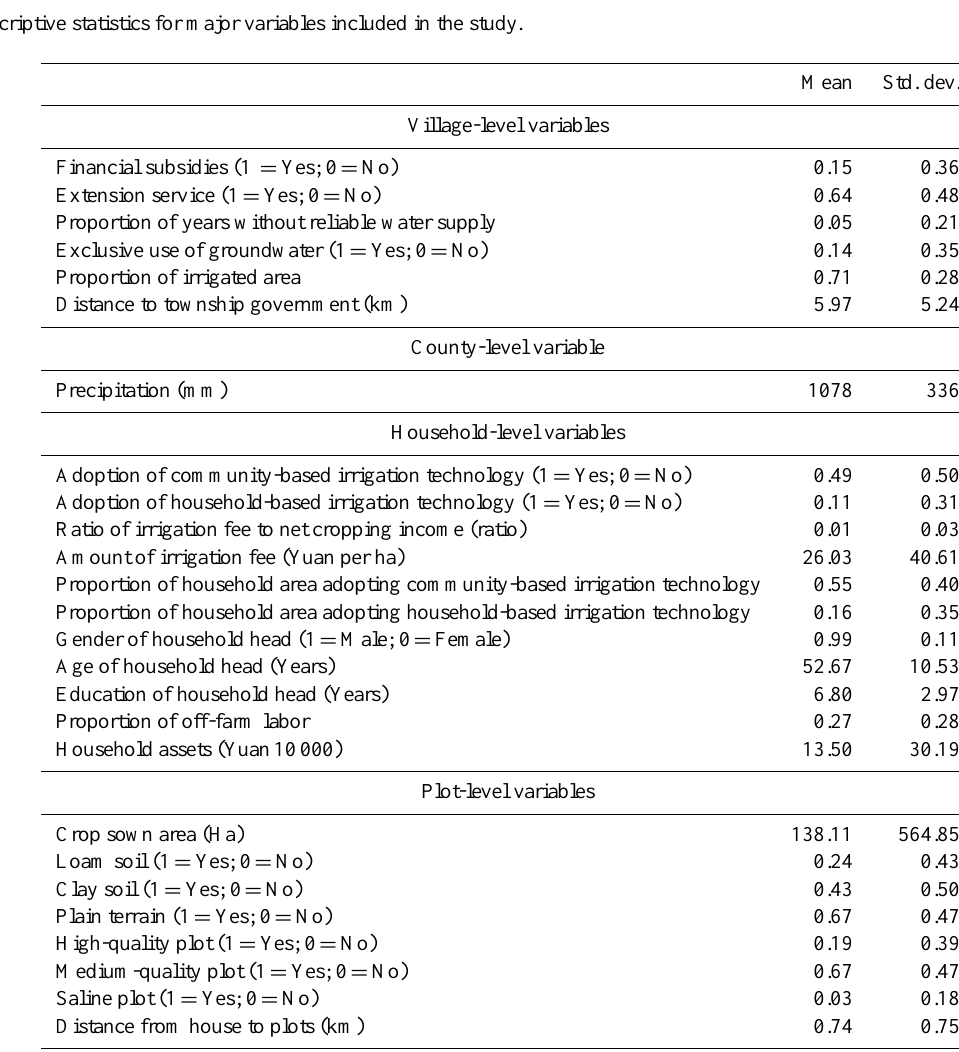
Table 1. Descriptive statistics for major variables included in the study.